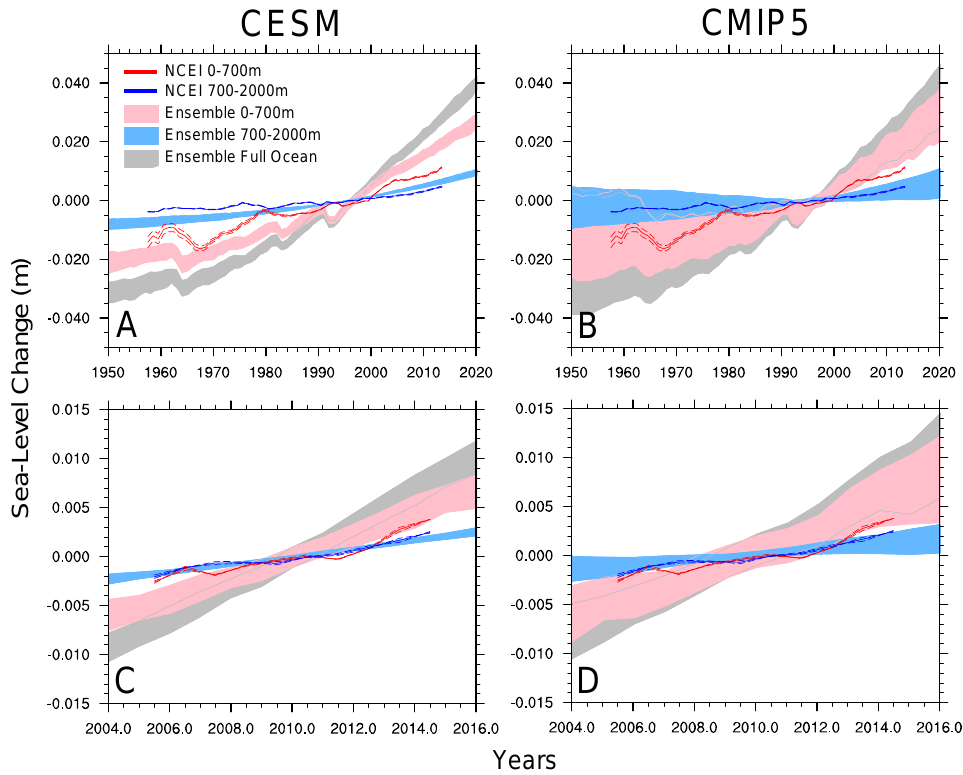
Figure 4. Timeseries of 95% model ensemble range of steric sea ‐ level change over different ocean depths. Observations from National Center for Environmental Information (NCEI) are overlaid, with dashed lines displaying uncertainty provided by the dataset. ( A ) and ( B ) display all available pentadal observations (1957–2013). ( C ) and ( D ) zoom in on yearly observations (2005–2015). Data is offset by the 1986–2005 average in ( A ) and ( B ). Data is offset by the 2005–2015 average in ( C ) and ( D ). Full ocean is defined as the entire available depth of each model ocean.